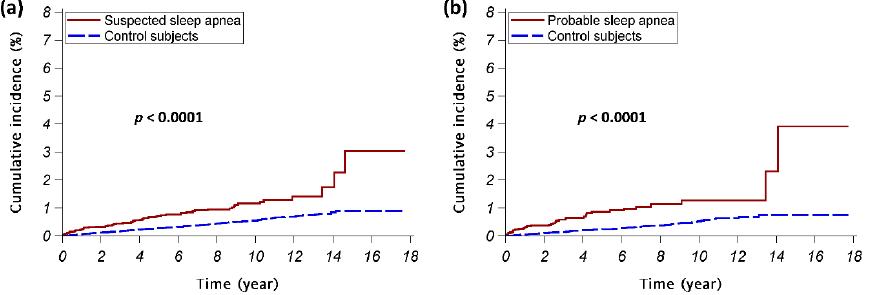
Figure 2. The cumulative incidences of temporomandibular disorder. The red continuous lines show the cumulative incidence of temporomandibular disorder for the sleep apnea patients; the blue dashed lines show the cumulative incidence of temporomandibular disorder for the control subjects. ( a ) Study arm A (the suspected sleep apnea cohort vs. control A cohort); ( b ) Study arm B (the probable sleep apnea cohort vs. control B cohort).